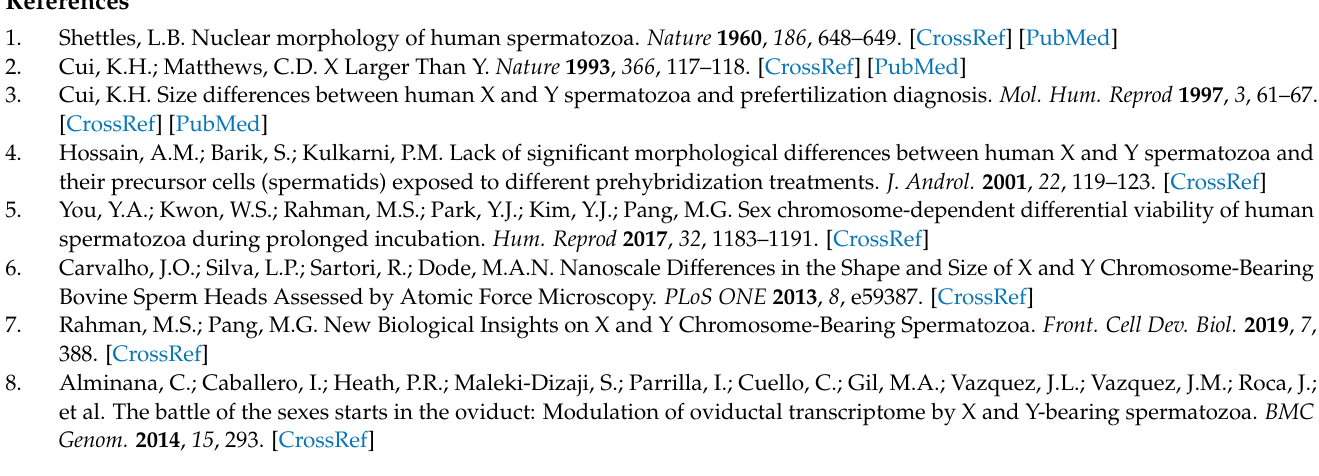
low-blastocyst, and bud of early stages of yellow catfish (B); Figure S4: Clustering of parental samples for WGRS (A), clustering of RNA-seq samples from five stages (B), and the number of maternal SNPs and zygotic SNPs identified from five stages of XX female fish and XY male fish, respectively (C); Figure S5: Comparison of expression patterns of sex determination genes between XX female and XY male yellow catfish; Table S1: DEGs from Y sperm vs. X sperm of yellow catfish, with thresholds of |log2FC| > 1.0 and padj < 0.05; Table S2: Hyper and hypomethylated regions identified from Y sperm vs. X sperm of yellow catfish, with thresholds of methylation difference ≥ 25% and q value < 0.01; Table S3: Maternal and zygotic genes and their expression FPKM in five stages of early embryonic development; Table S4: PGC correlated maternal and zygotic genes and their expression FPKM in five stages of early embryonic